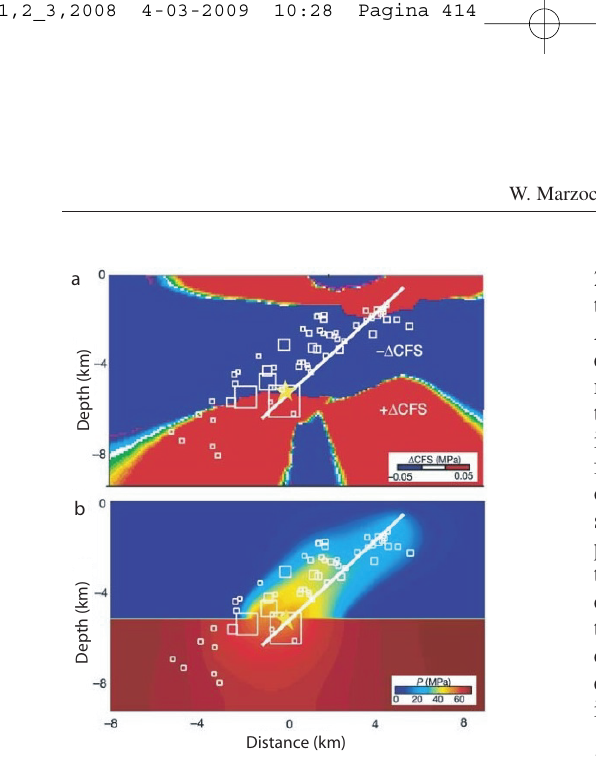
Fig. 7. Comparison of aftershock data to CFF changes and pore pressure variations. a) there is no correlation between aftershock occurrence and posi- tive CFF variations; b) aftershocks occur where the pore pressure is